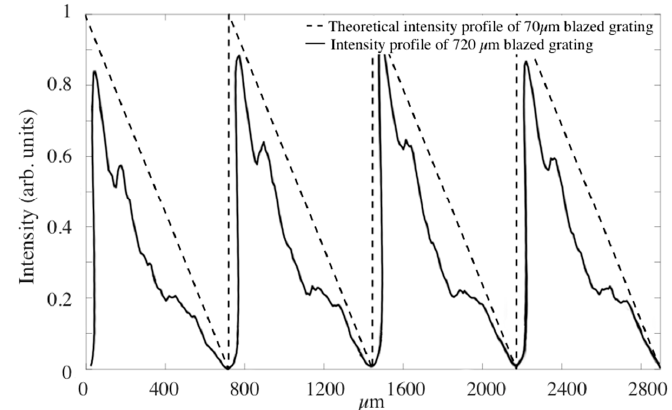
Figure 9. Intensity profile provided by the LCoS across a vertical line of the image recorded using the CCD camera on the material plane and theoretical profile of blazed grating.